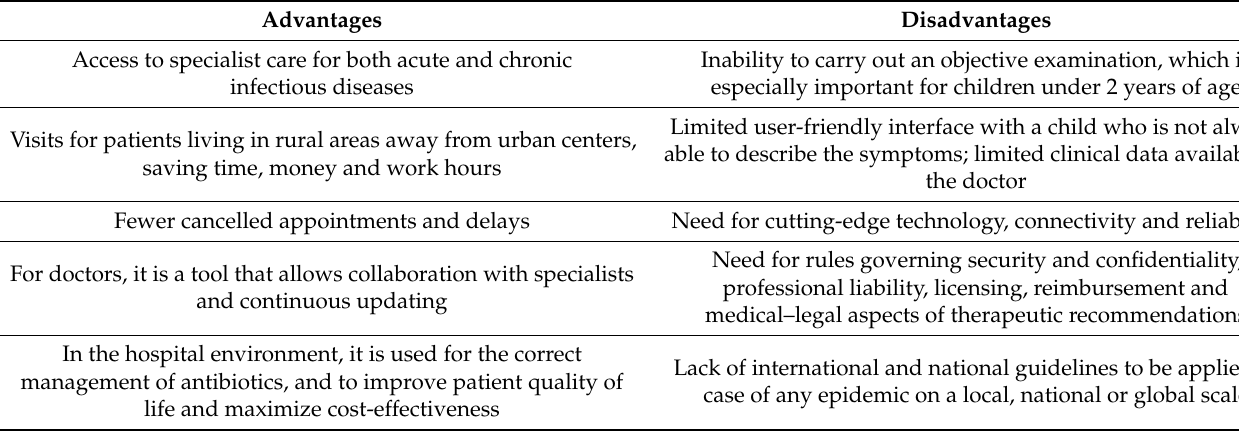
Table 1. Advantages and disadvantages of the use of telemedicine in